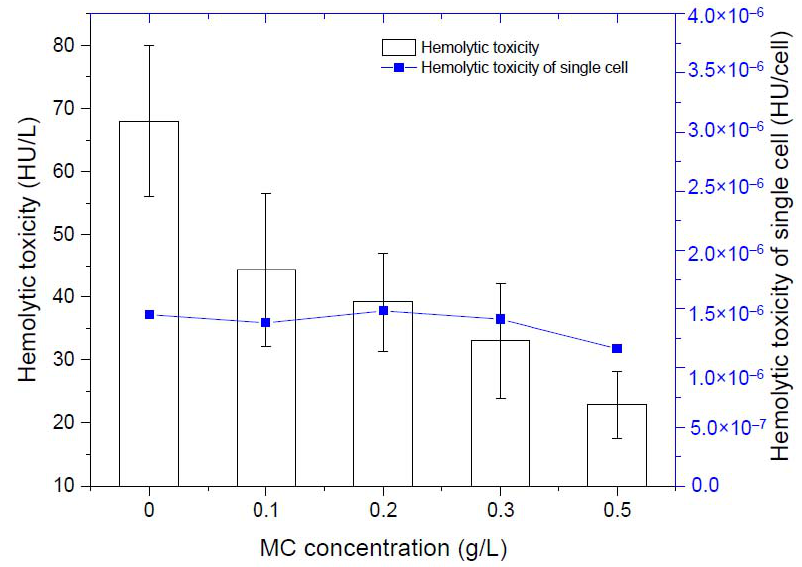
Figure 2. Changes of hemolytic toxicity of residual algal cells.